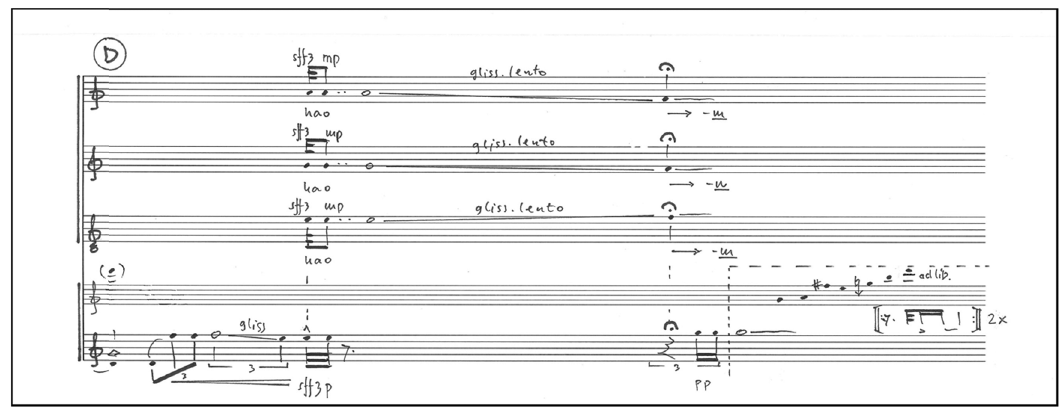
Figure 1: The fi rst bar of part D of the third movement of Ørenslyd. Ritus